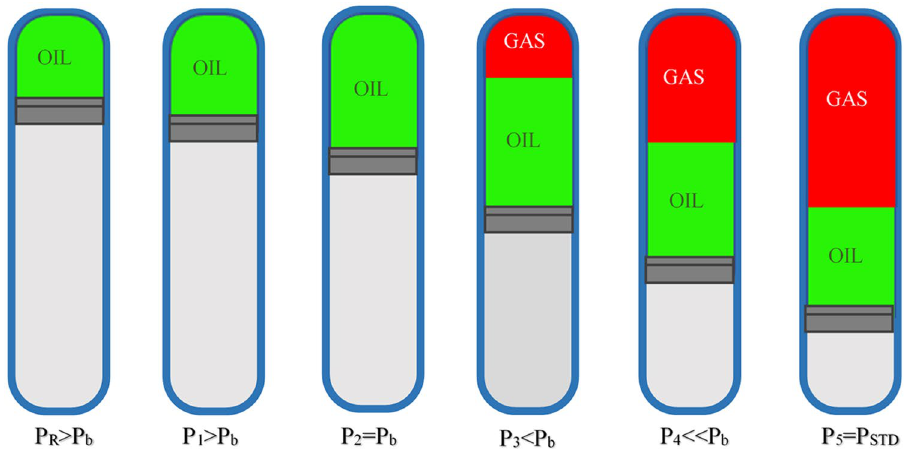
Fig. 1 Constant composition expansion (CCE)